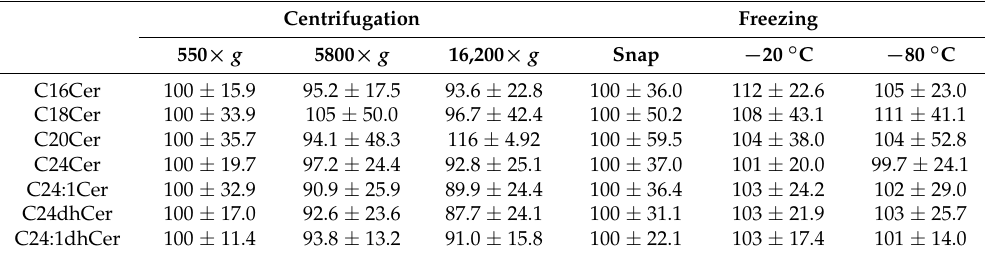
Table 6. Effect of sample preparation on relative sphingolipid levels in human blood samples.